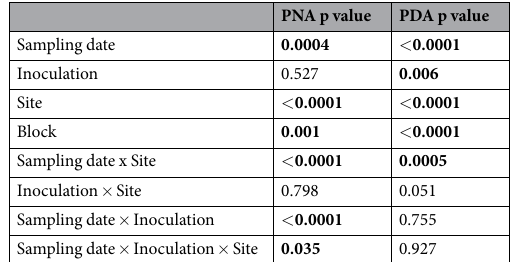
Table 1. Overall effects of maize inoculation by Azospirillum lipoferum CRT1 on potential nitrification activity, PNA, and potential denitrification activity, PDA, identified using ANOVA with inoculation, site, and sampling date as fixed effects and the factor block as a random effect.